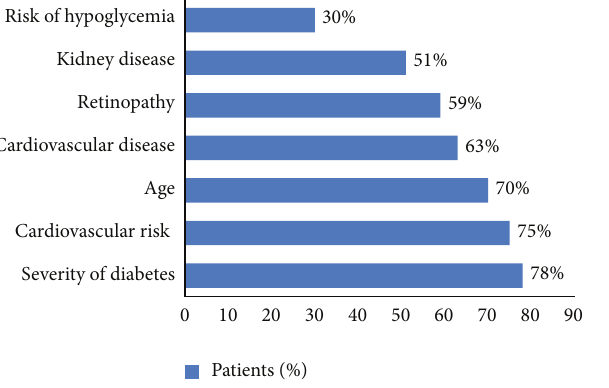
Figure 2: Factors considered by GPs when selecting glucose lowering therapy in CKD patients. Among the top five factors that GPs took into account, severity of diabetes was the most frequently mentioned while only one GP out of three mentioned the risk of hypoglycaemic episodes.